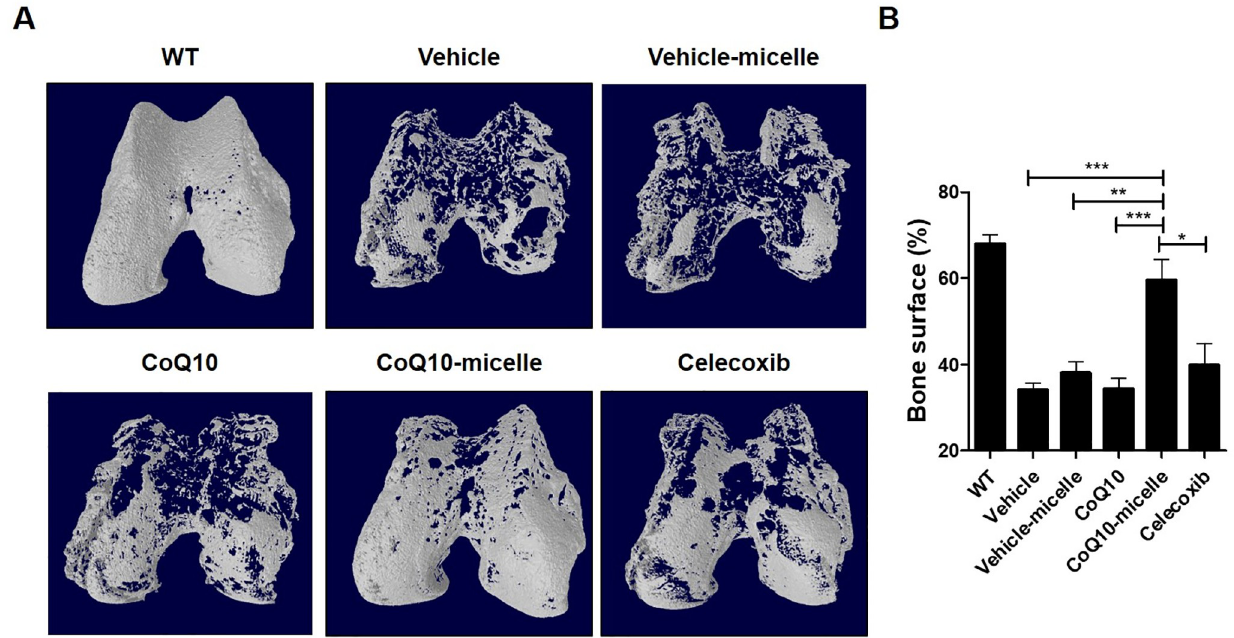
Fig 3. CoQ10-micelles reduced bone erosion. (A) Micro-CT was performed to measure bone loss in a WT group, a vehicle group, a CoQ10-micelle group, and a celecoxib group (N = 3 per group). (B) The bar graph shows the average bone surface density percentages. Data are shown as means ± S.E.Ms. Statistical significance was assessed using the Bonferroni test. �� p < 0.01.